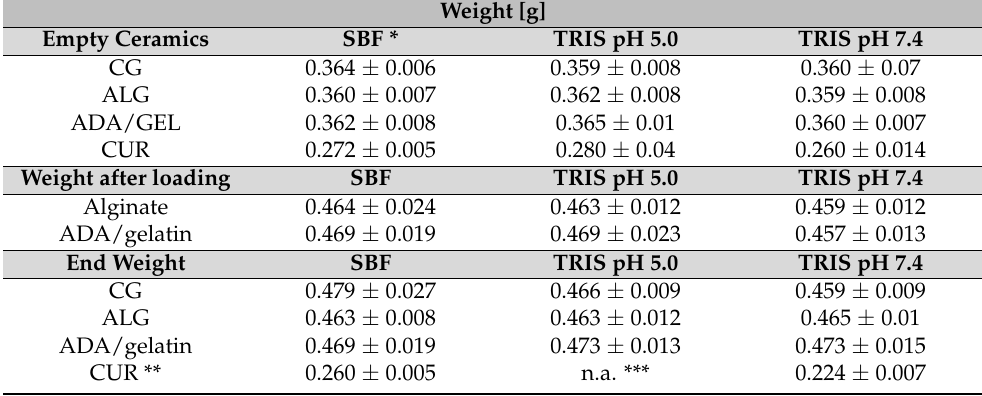
Table 6. Weight development of the different ceramics over the experimental